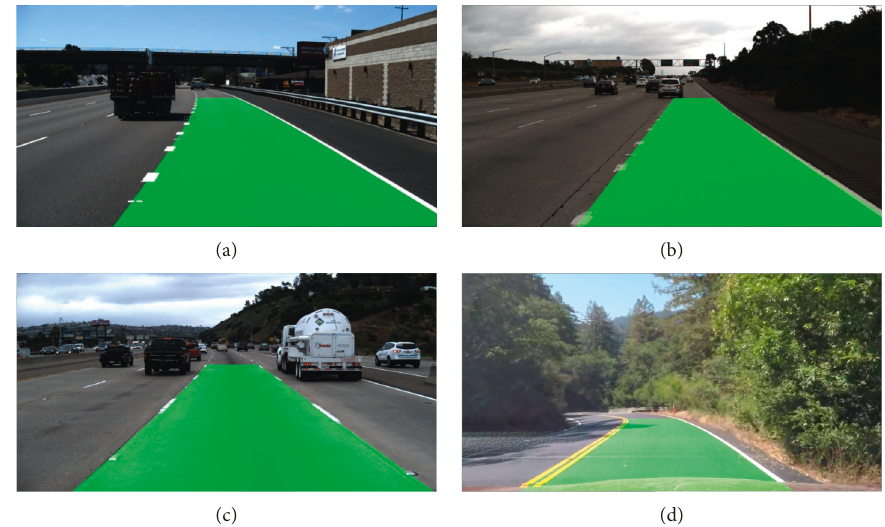
Figure 18: Results of lane detection for different conditions: (a) sunny, (b) cloudy weather, (c) traffic, and (d) mountain road.